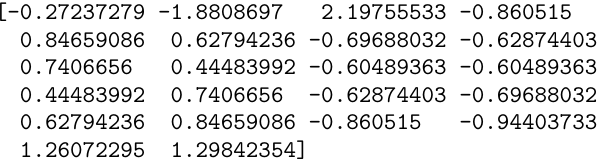
The corresponding response function is shown in Fig. 24.